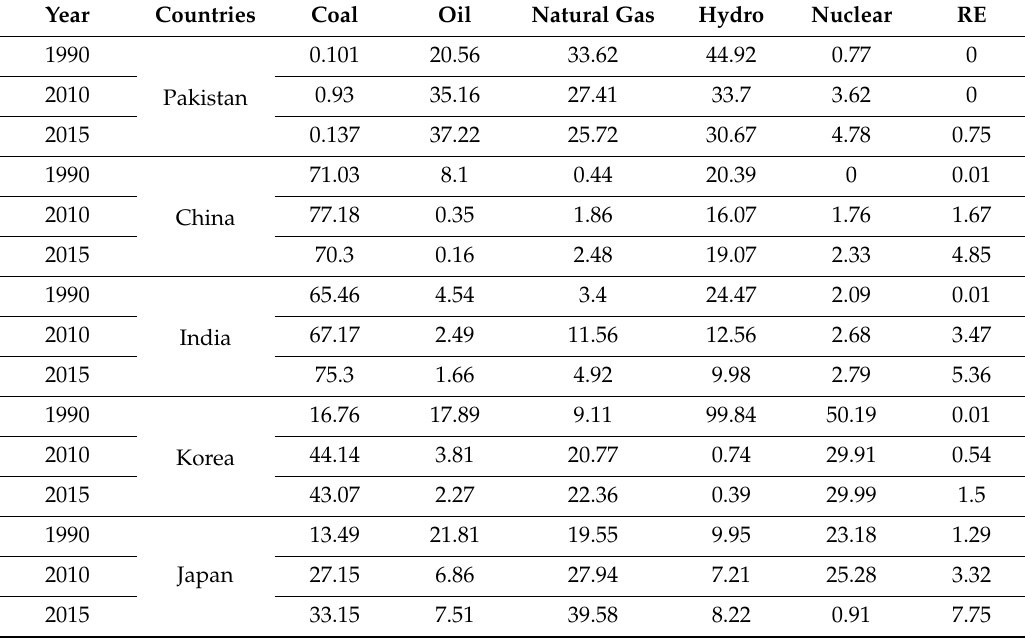
Collected by the investigator from WDI of WB. Figure 1. Electricity generation by source for Pakistan 2019 (Source: Ministry of finanace, Pakistan).